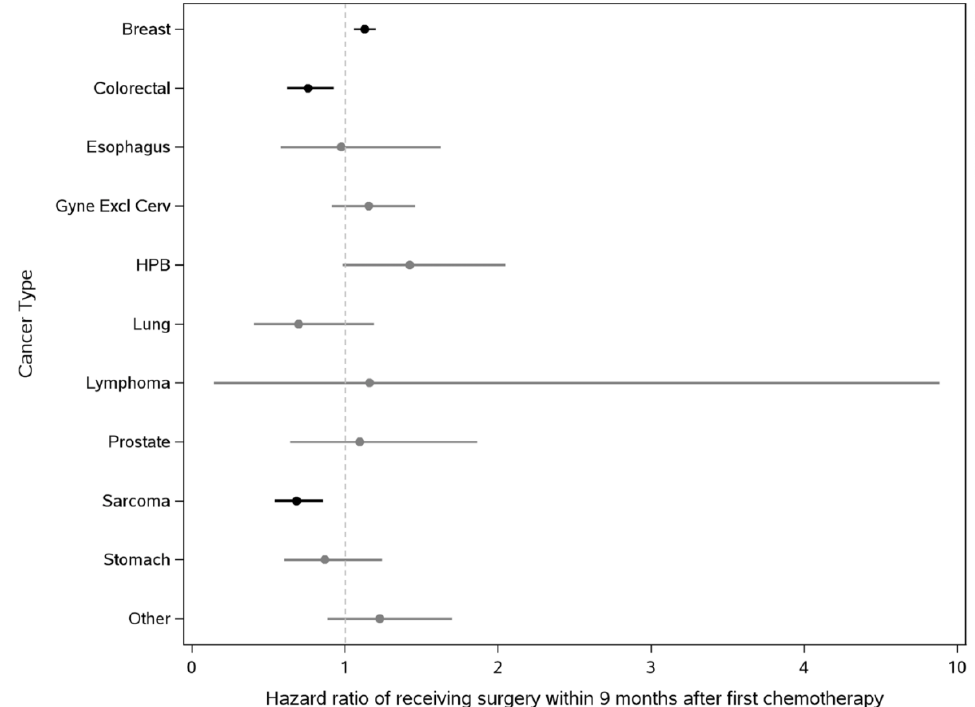
Figure 2. The COVID-19 pandemic impact on the use of surgery after chemotherapy initiation by cancer type. Legend: We report the subdistribution hazard ratios (sHRs) and associated 95% confi- dence intervals of receiving surgery within 9 months after chemotherapy initiation in the pandemic relative to pre-pandemic period for each cancer type. sHRs were computed from a multivariable Fine-Gray regression model, where interaction of the COVID-19 pandemic indicator (pandemic vs. pre- pandemic) with cancer type was included. “Other” includes central nervous system, cervical, endocrine, genitourinary, head and neck, and other cancer types with unknown or ill-defined pri- mary site. sHRs that are significantly different from 1 were highlighted in black, while insignificant sHRs were plotted in gray. A sHR > 1 implies an increased use of surgery within 9-month following chemotherapy initiation in the pandemic relative to pre-pandemic period.